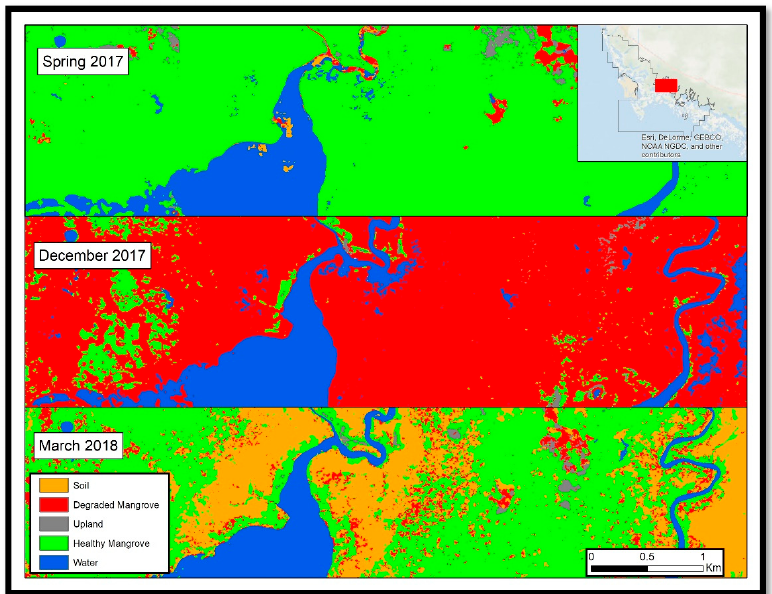
Figure 6. Subset of the study area (inset map) reflecting various stages of mangrove change. Healthy mangrove dominated the reserve in early 2017 (top), but was largely degraded following Hurricane Irma (center), and either recovered or died by the following spring (bottom).